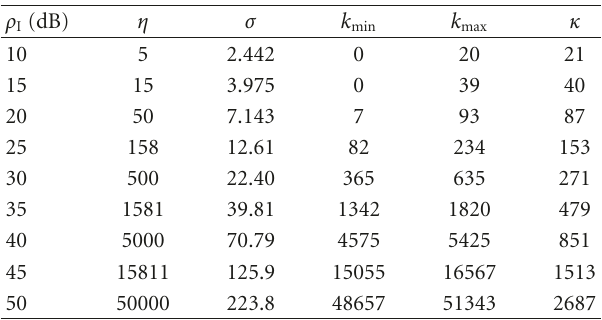
Table 1: Parameters of the series truncation for T = 6 and ρ N = 1000